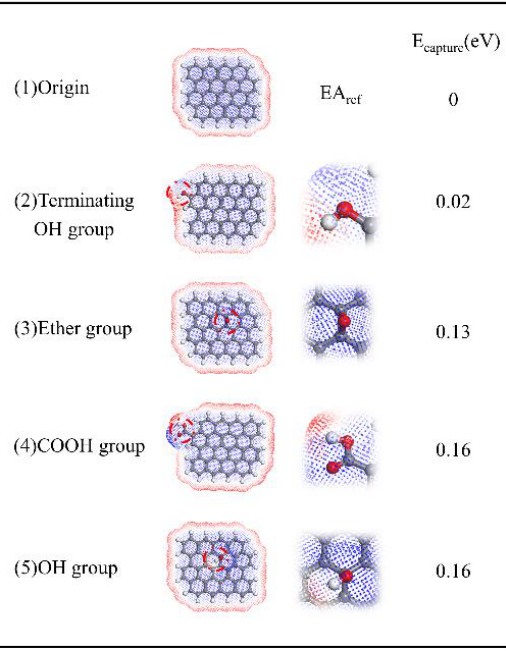
Figure 3. The electron capture energy of different groups in the nano graphene oxide: (1) the electron capture energy of the original molecule; (2) the electron capture energy of the terminating OH group in the nano graphene oxide; (3) the electron capture energy of the ether group in the nano graphene oxide; (4) the electron capture energy of the COOH group in the nano graphene oxide; (5) the electron capture energy of the OH group in the nano graphene oxide.